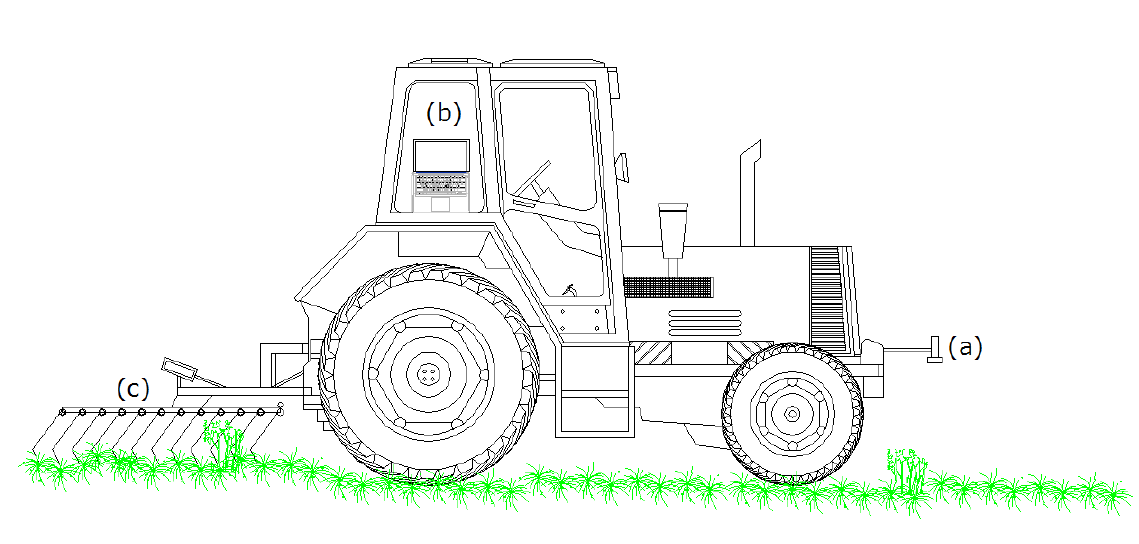
Figure 1. Schematic of the tractor with the three discrete subsystems: ( a ) the ultrasonic sensor mounted in front of the tractor; ( b ) the computational unit responsible for gathering the sensor data, interpreting them, running the decision making algorithm and controlling the actuator; and ( c ) the harrow